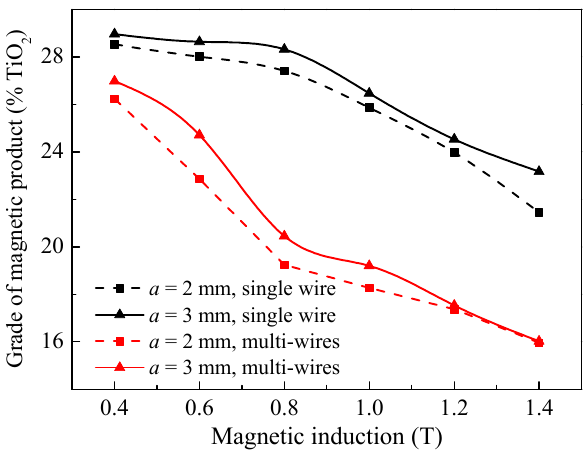
Figure 10. Capture selectivity of single wire and multi-wires.